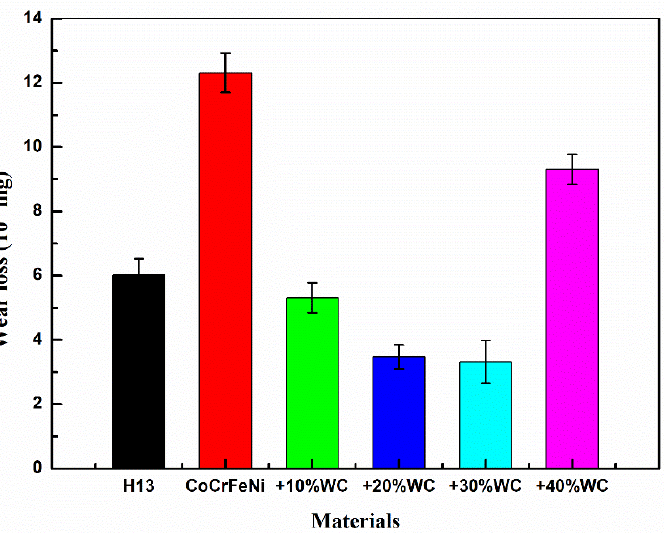
Figure 9. The wear mass loss of coatings: H13 (black); CoCrFeNi HEAC (red); CoCrFeNi HEACC (10 wt.% WC: green); CoCrFeNi HEACC (20 wt.% WC: blue); CoCrFeNi HEACC (30 wt.% WC: cyan); CoCrFeNi HEACC (40 wt.% WC: purple).